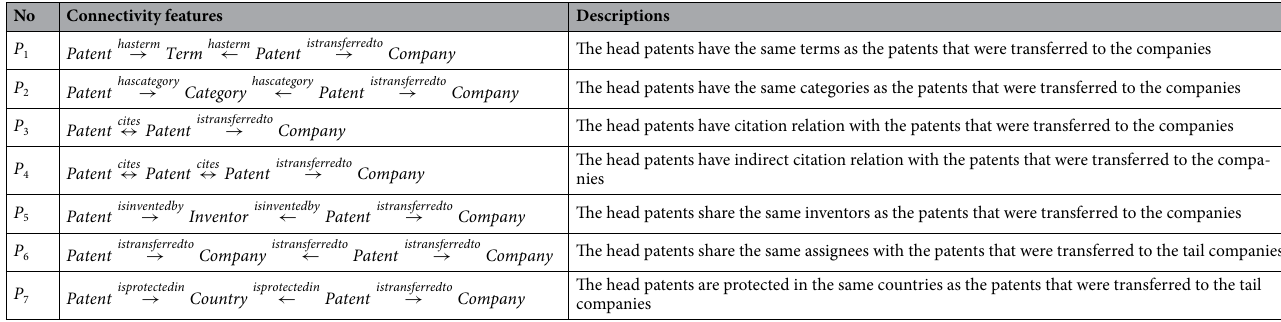
Table 2. Connectivity features and their